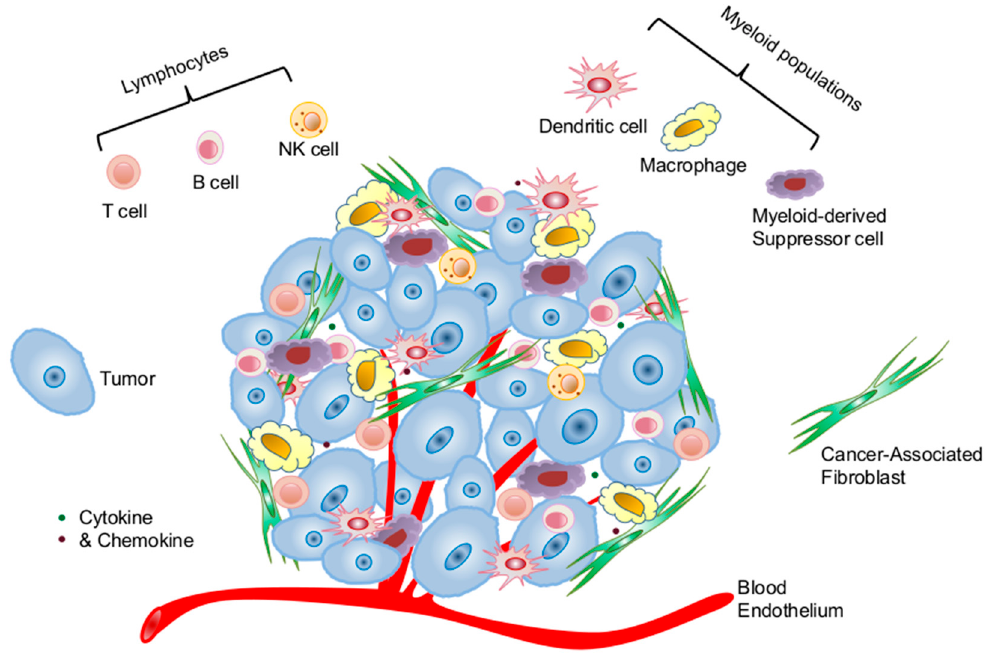
Figure 1. Cellular constituents of the tumor microenvironment that shape tumor immunological landscape. The tumor microenvironment consists of complex cellular and molecular and constituents. The cellular constituents consist of immune cells of hematopoietic origin and stromal cells of non-hematopoietic origin. The immune cell compartment comprises tumor-infiltrating lymphocytes of T, B, and natural killer cells and tumor-associated myeloid populations of dendritic cells, macrophages, and myeloid-derived suppressor cells. The stromal compartment consists of cancer-associated fibroblasts and endothelial cells of the lymphatic and blood vasculature. Trp53 inactivation has been observed in some of the cellular subpopulations of the tumor microenvironment, which compromises the proper balance of host immunity by promoting chronic inflammation and tumor progression.